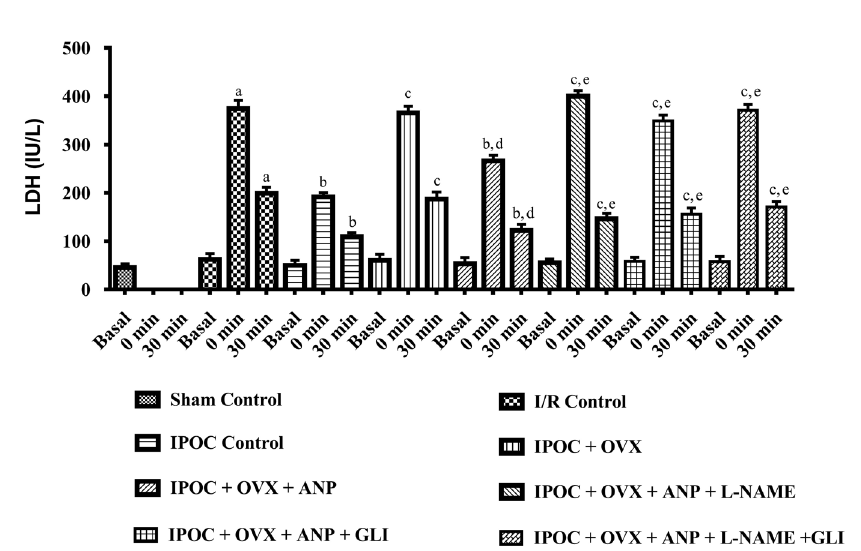
FIGURE 8 - Effect of I/R on release of LDH, effect of IPTC on release of LDH in normal and OVX rat heart, effect of ANP perfusion, effect of L-NAME and ANP perfusion, effect of Glibenclamide and ANP perfusion and effect of L-NAME, Glibenclamide and ANP perfusion on release of LDH in OVX rat heart. I/R denotes ischemicreperfusion; IPTC denotes ischemic postconditioning; OVX denotes ovariectomy; ANP denotesatrial natriuretic peptide; L-NAME denotes N- nitro L-arginine methyl ester. Values are expressed as mean ±S.D, a = p<0.05 vs. sham control; b = p<0.05 vs. 1 I/R control; c = p<0.05 vs. IPTC in normal rat heart; d =